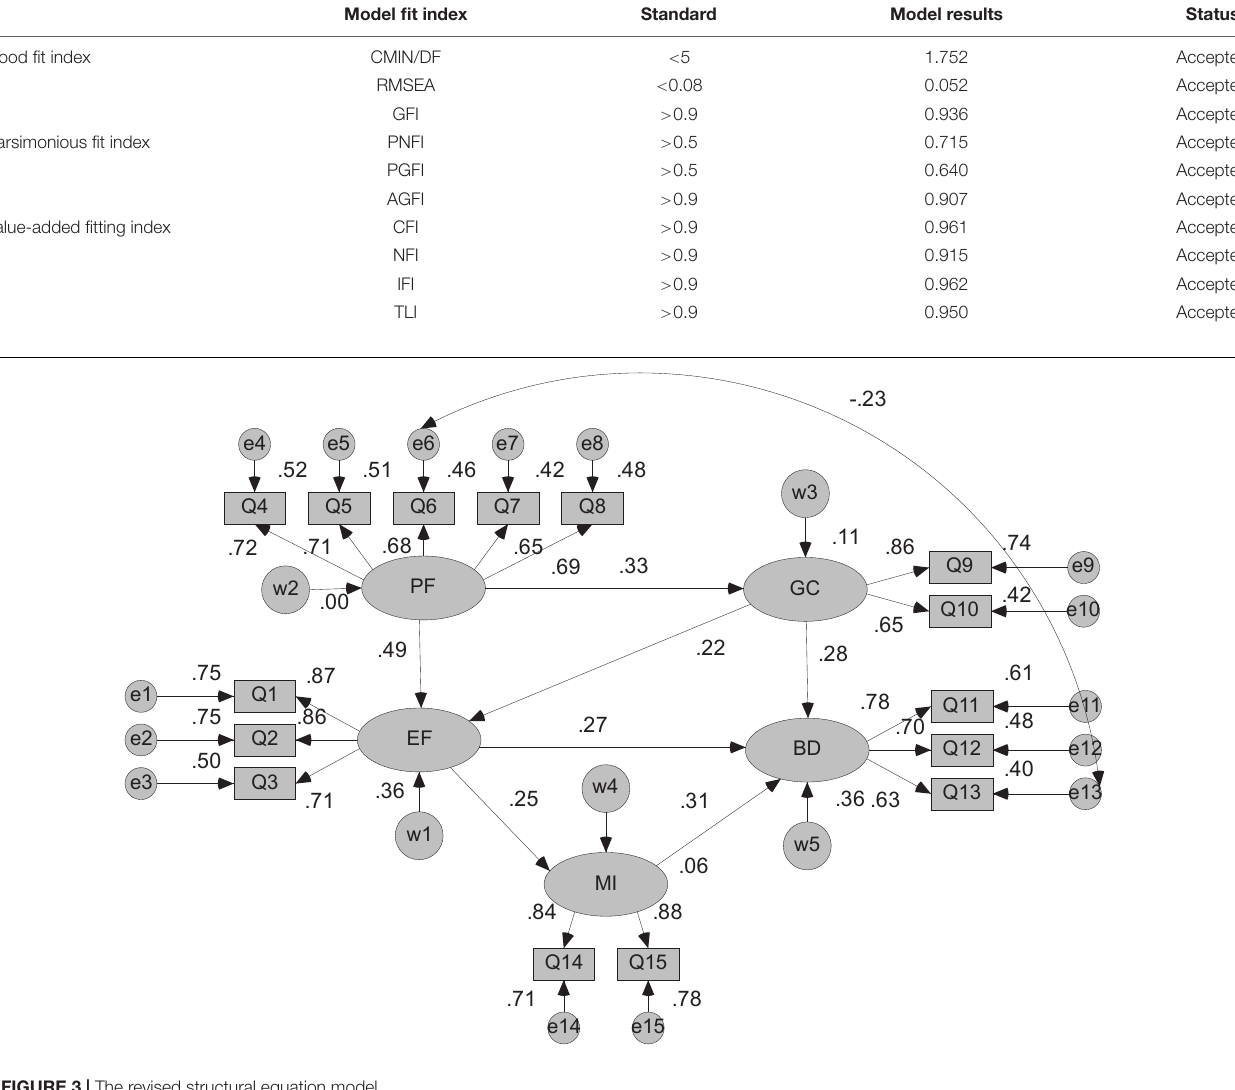
FIGURE 3 | The revised structural equation